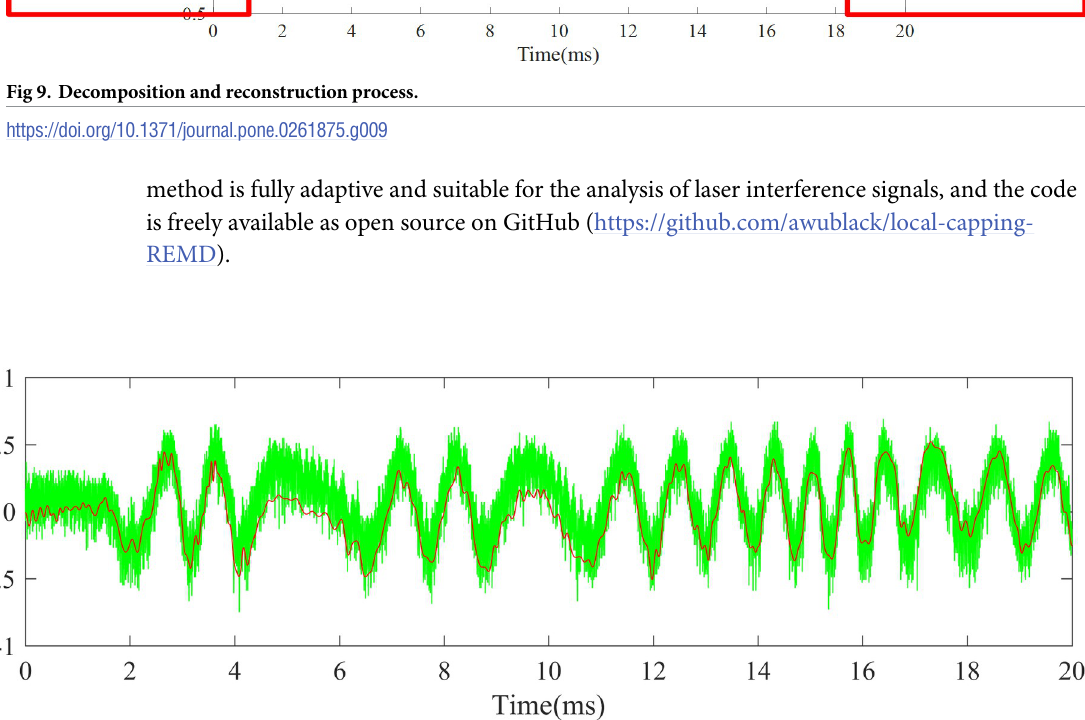
Fig 10. Comparison of denoised signal and the original